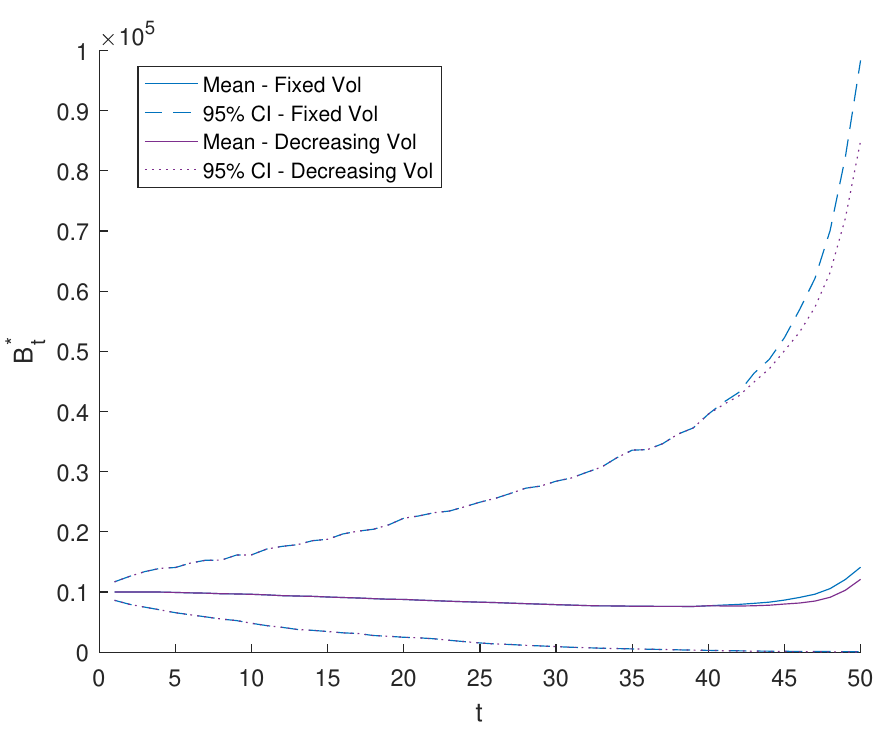
Figure 8. Fixed Volatility vs. “Step Down” Volatility—Real.